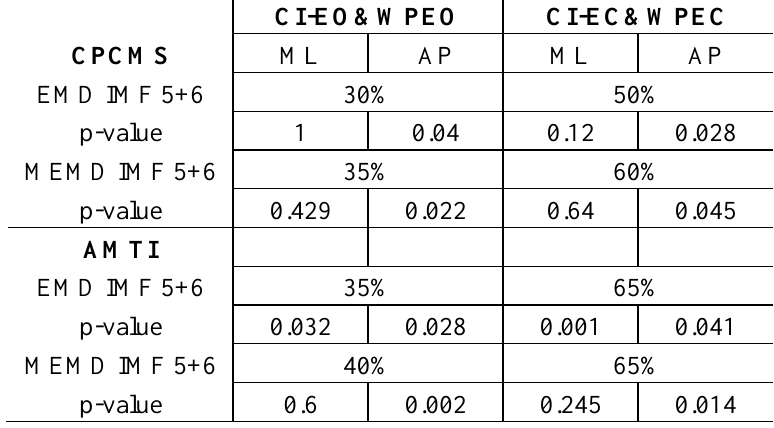
Table 7. Compare EMD-Enhanced MSE and MEMD-Enhanced MSE use IMF